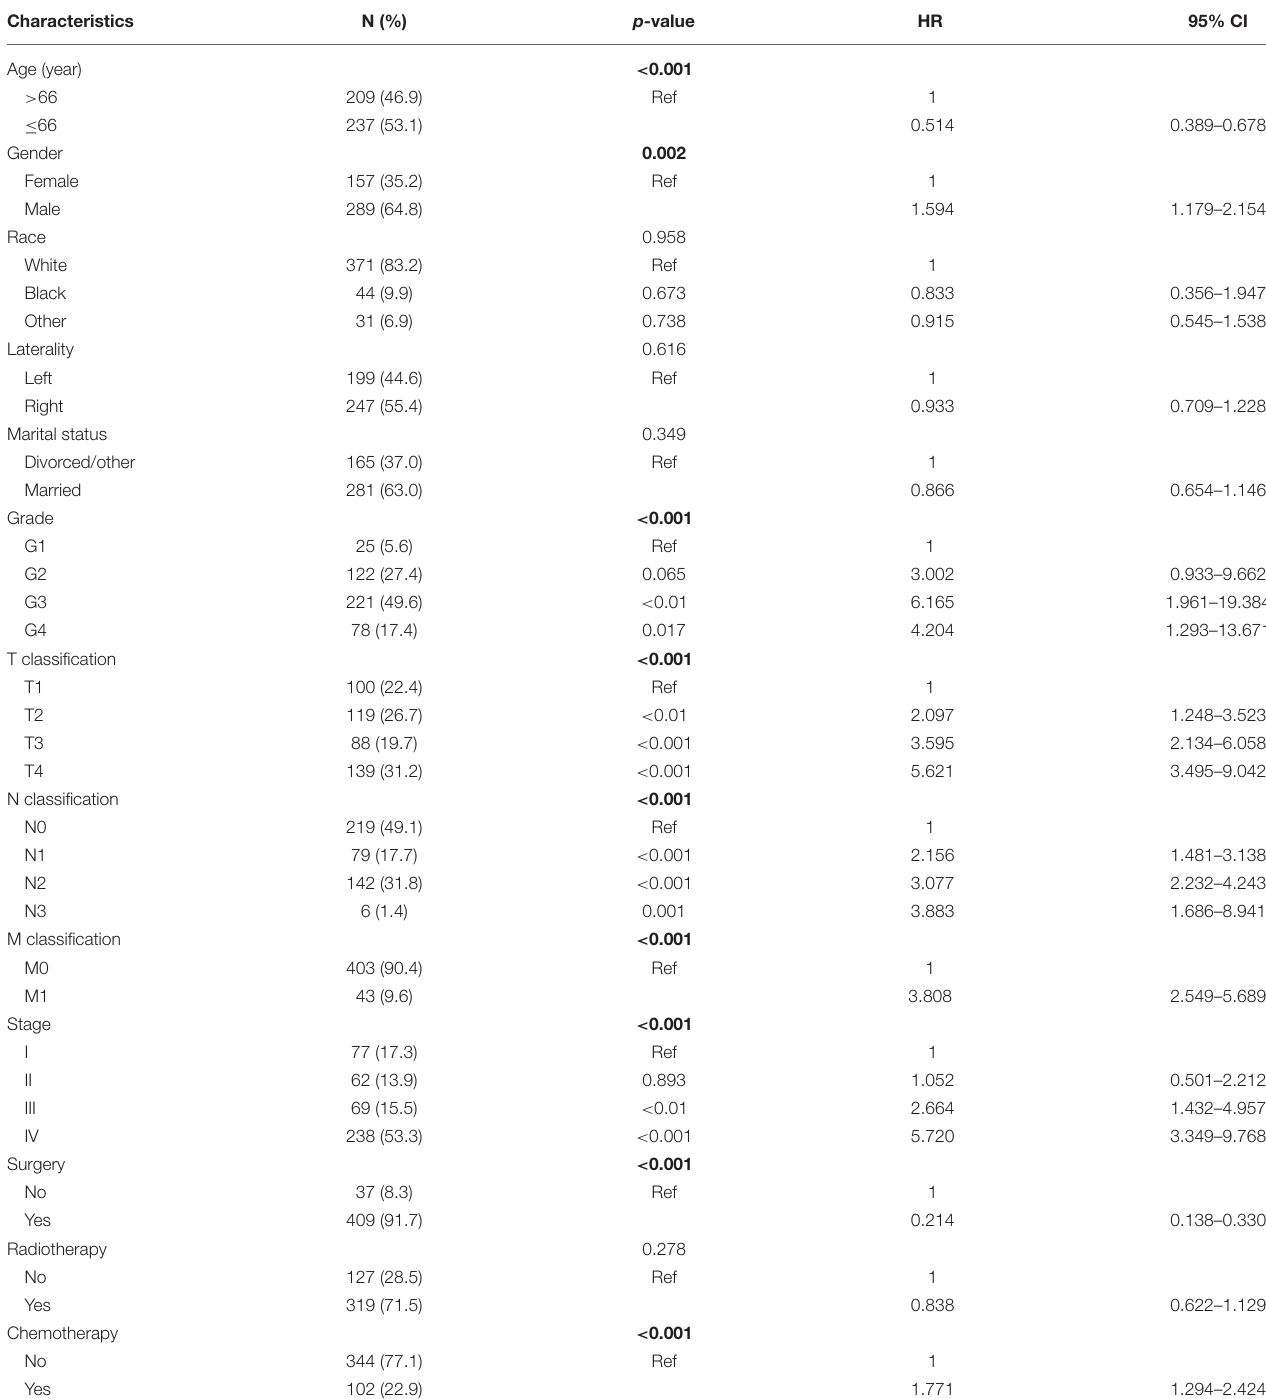
TABLE 1 | Demographic and clinicopathological characteristics of patients and univariate Cox regression analyses of overall survival.